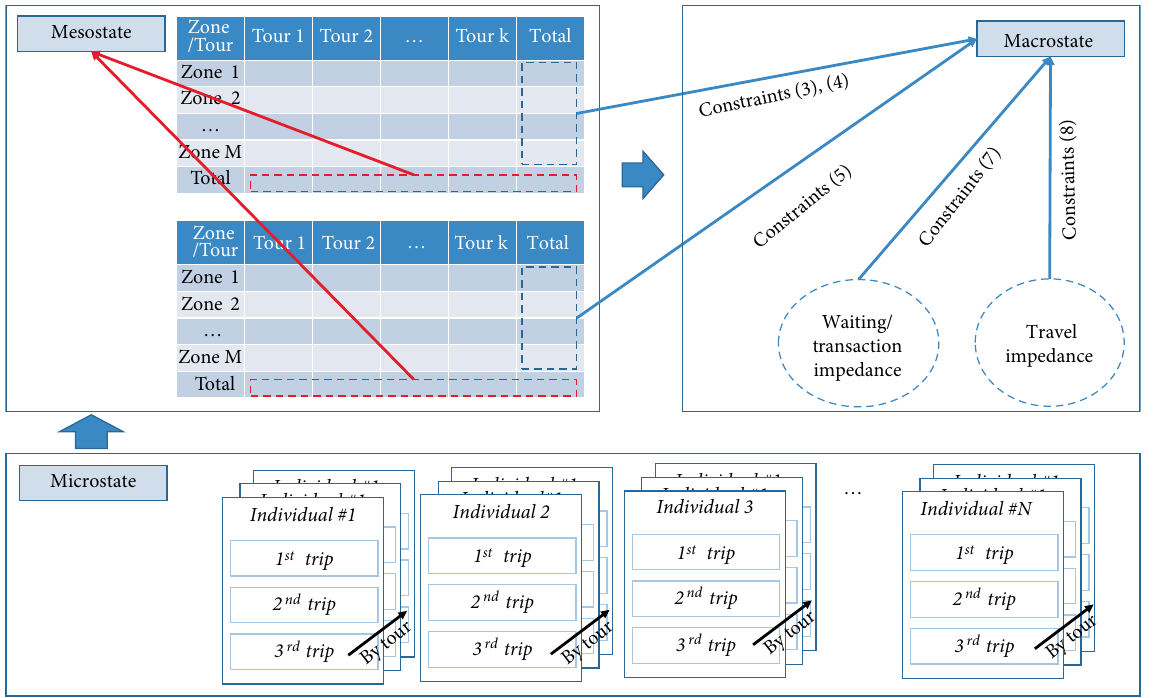
Figure 4: Coastal truck tour-based entropy maximization